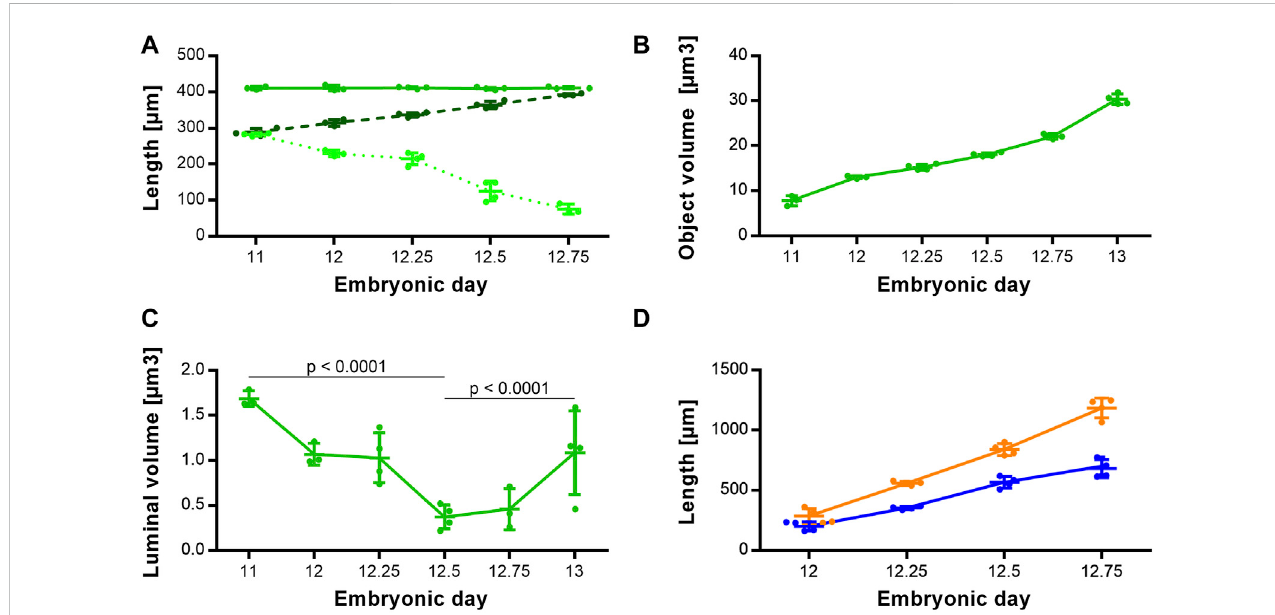
FIGURE 4 Morphometrical growth dynamics of the intermediate compartment, trachea and esophagus. (A) Length measurements of the intermediate compartment of the foregut (Solid green line: TE bifurcation to the most ventrocranial point; p = 0.9757. Dashed dark green line: TE bifurcation to the most dorsocranialpoint; p < 0.0001.Dottetlightgreenline:Distancefromthemostventrocranialtothemostdorsocranialpoint; p < 0.0001). (B) Objectvolumesof the intermediate compartment of the foregut; p < 0.0001. (C) Luminal volumes of the intermediate compartment of the foregut. (D) Length measurements of the trachea (blue line) and esophagus (orange line); both p <